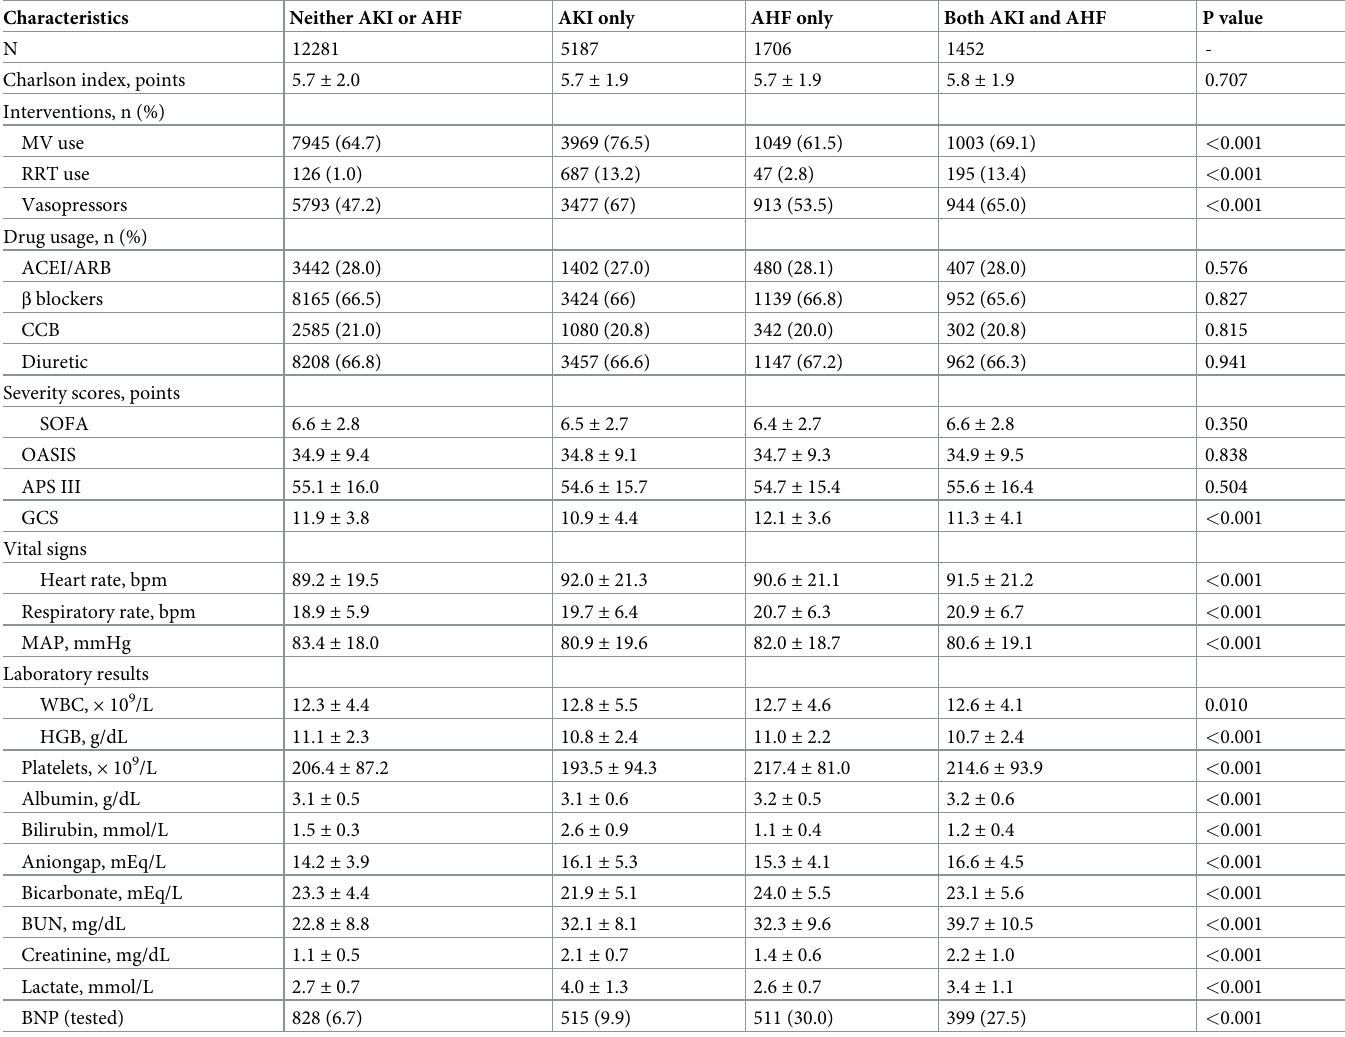
Table 2. The baseline characteristics of all patients in training cohort categorized by AHF and AKI.